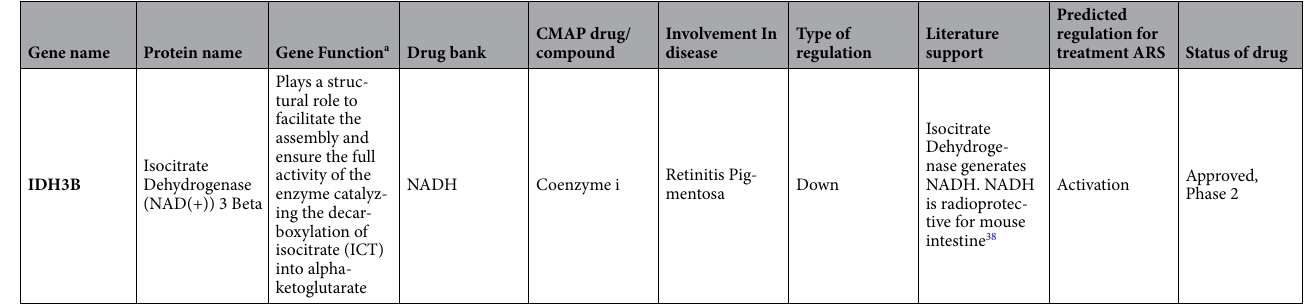
Table 2. Potential drug targets identified for acute radiation syndrome. a The gene functions were obtained from the Uniprot database 39